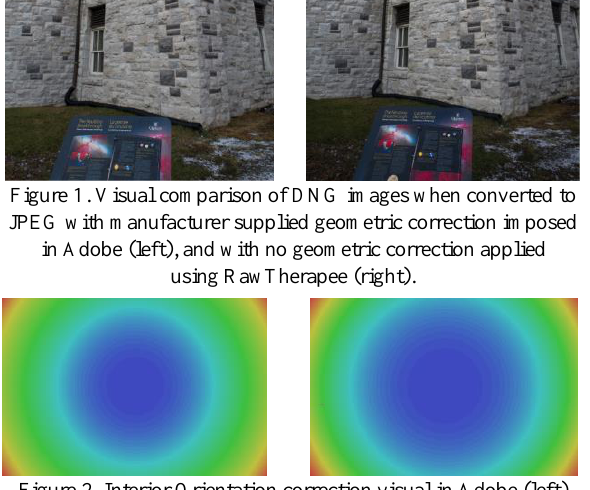
correction generated from the image sets (Figure 2) with and